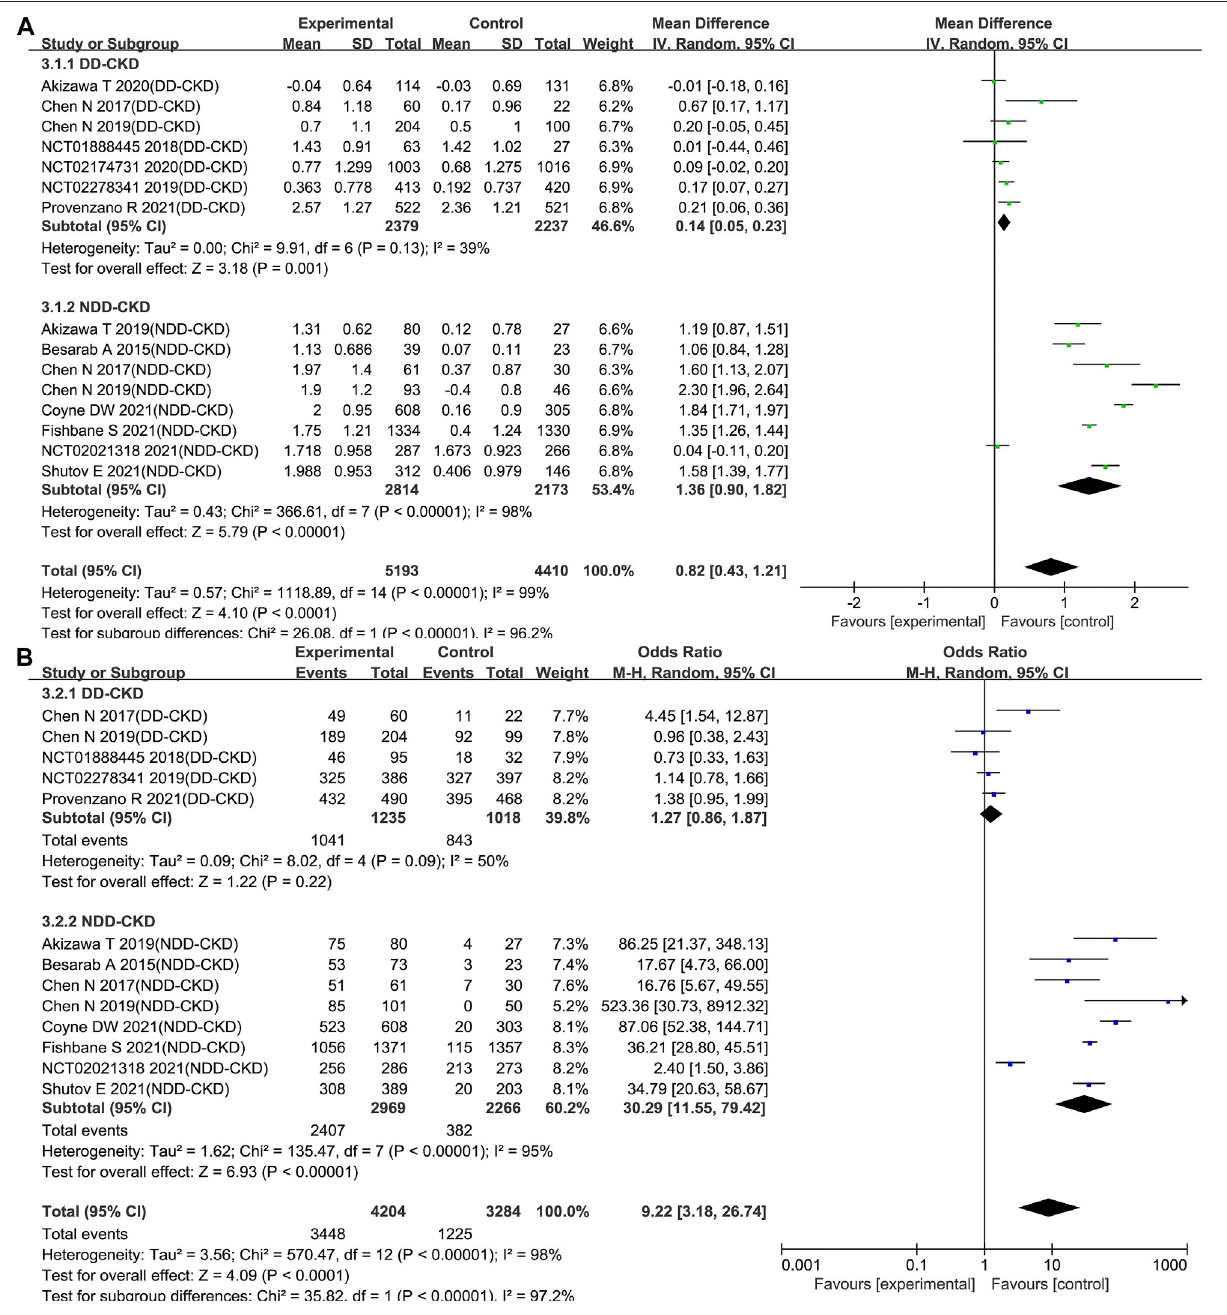
Frontiers in Pharmacology |